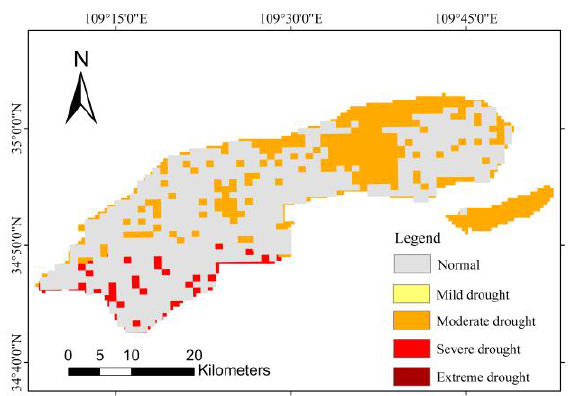
Figure 8. Comprehensive monitoring of drought conditions in